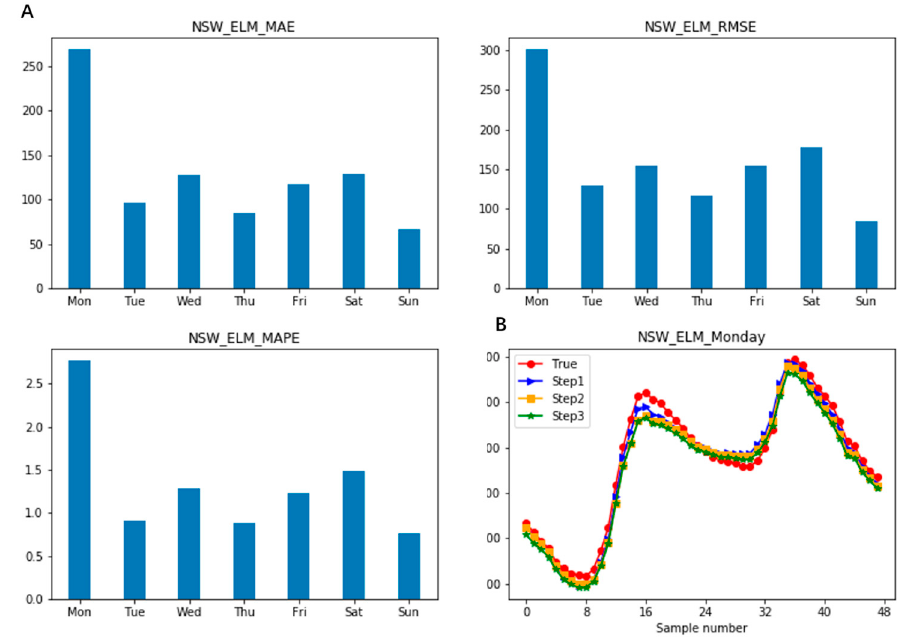
Figure 3. Comparison of the 1-step, 2-step, and 3-step forecasting results of ELM on Monday. ( A ): three evaluation metrics results of ELM. ( B ): ELM forecasting results on Monday.